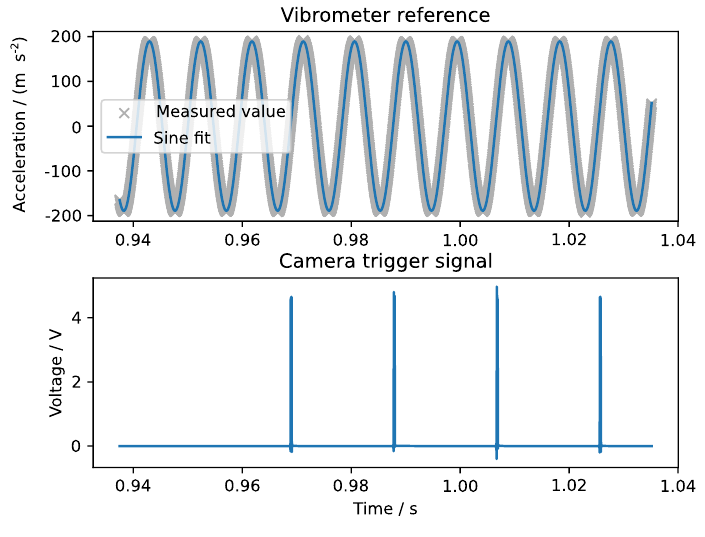
Figure 6. Vibrometer and camera trigger signals. Table 1. Fitted sine